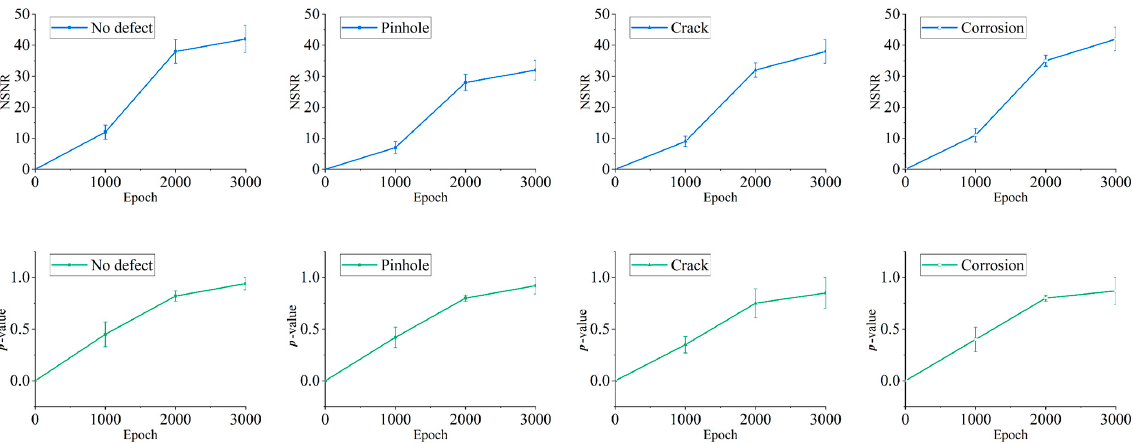
Figure 5. PSNRs and p -values of generated ultrasonic signals with no defect, pinhole, crack, and corrosion.